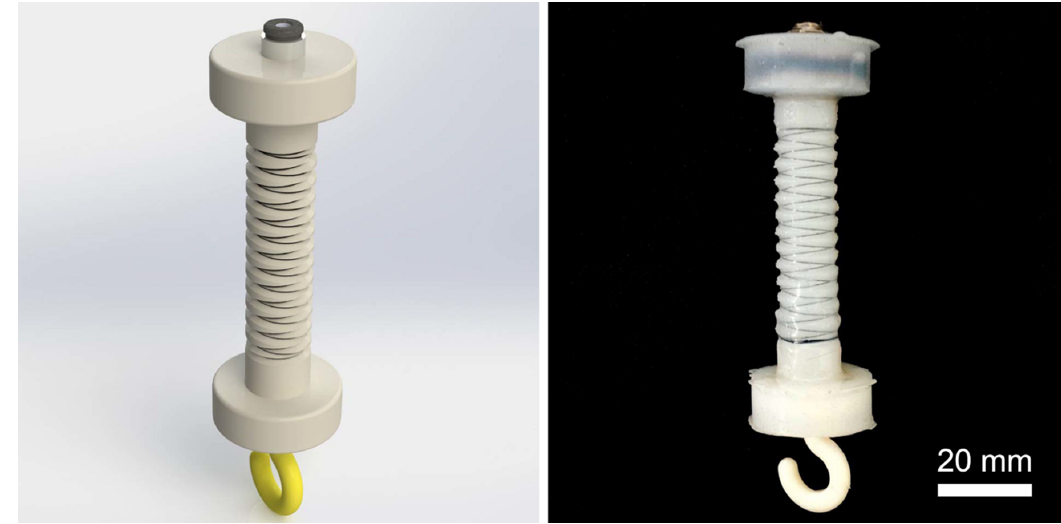
Figure 13. Comparisons of different models to experimental design of reverse pneumatic artificial muscles (rPAMs) [12] (Open Access).